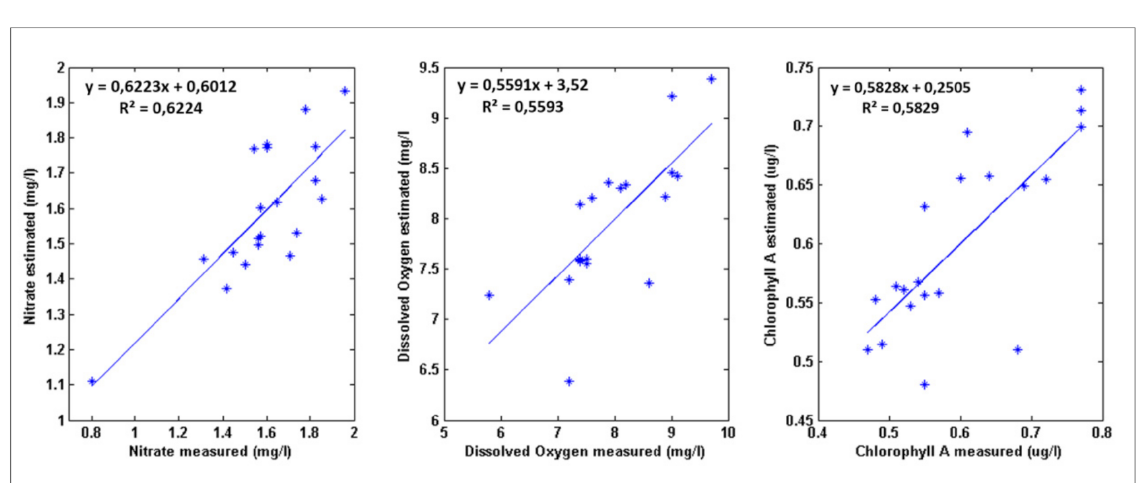
Figure 5. Water quality parameters measured versus estimated through the models (best models’